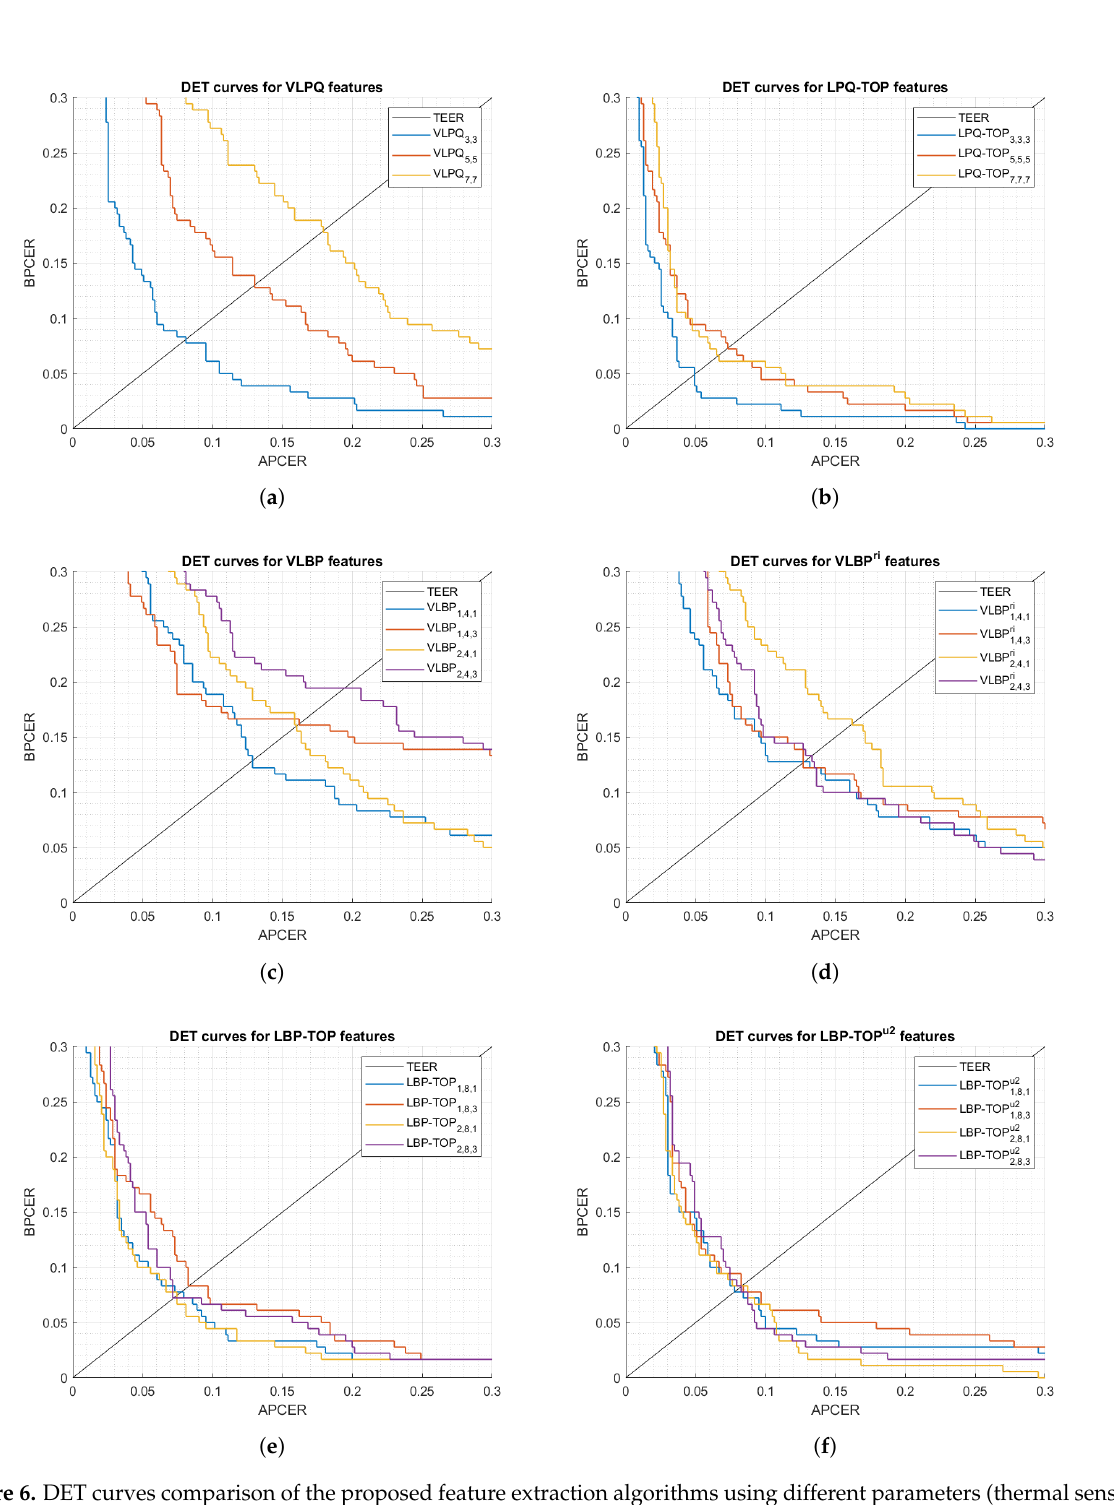
Figure 6. DET curves comparison of the proposed feature extraction algorithms using different parameters (thermal